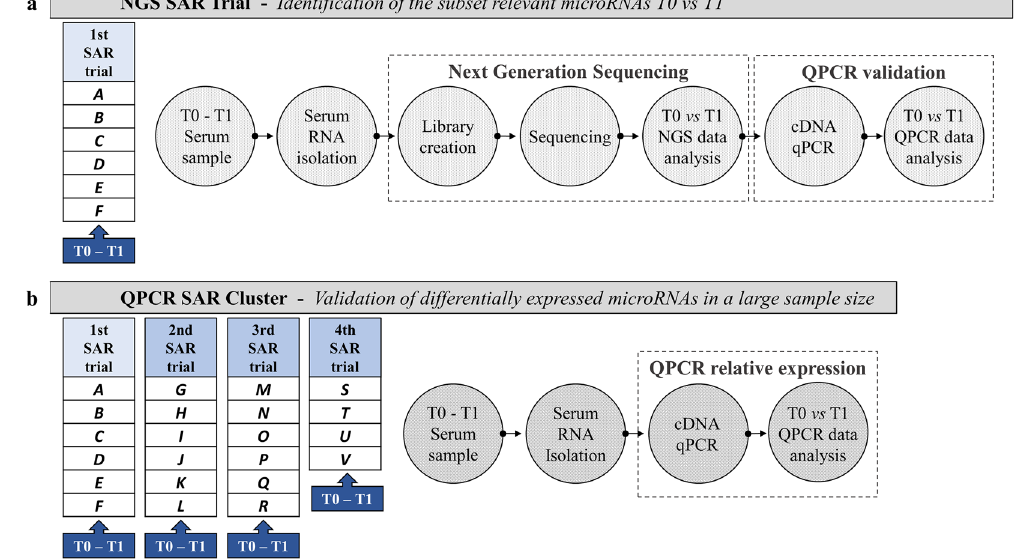
Figure 1. Research flowchart. The upper part of figure (a) shows the six dogs included in the NGS SAR Trial. The serum of six dogs was collected at two experimental time points (T0 and T1), RNA was extracted and processed for next-generation sequencing miRNome. The figure below (b) shows the second part of the research plan referred to as QPCR SAR Cluster. This part of the study includes blood dog sampling at T0 and T1 of the 2nd, 3rd, and 4th SAR trials. Serum RNA was extracted, reverse transcribed, and only the microRNAs differently expressed, detected in NGS SAR Trial, were validated by qPCR. The figure is created by G. Guelfi using PowerPoint 2021, Microsoft Corporation,